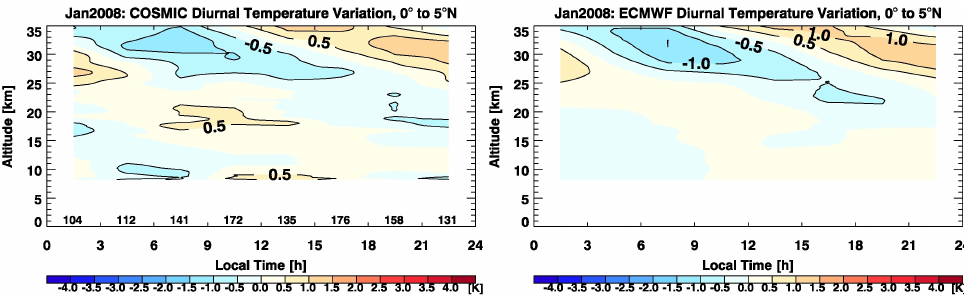
Fig. 16. COSMIC data show the diurnal tide near the equator (left panel) which compares well with the ECMWF tides (right panel). Poleward of about 50 degrees the sampling density is too small and natural variability swamps the diurnal signal (Pirscher et al., 2010).